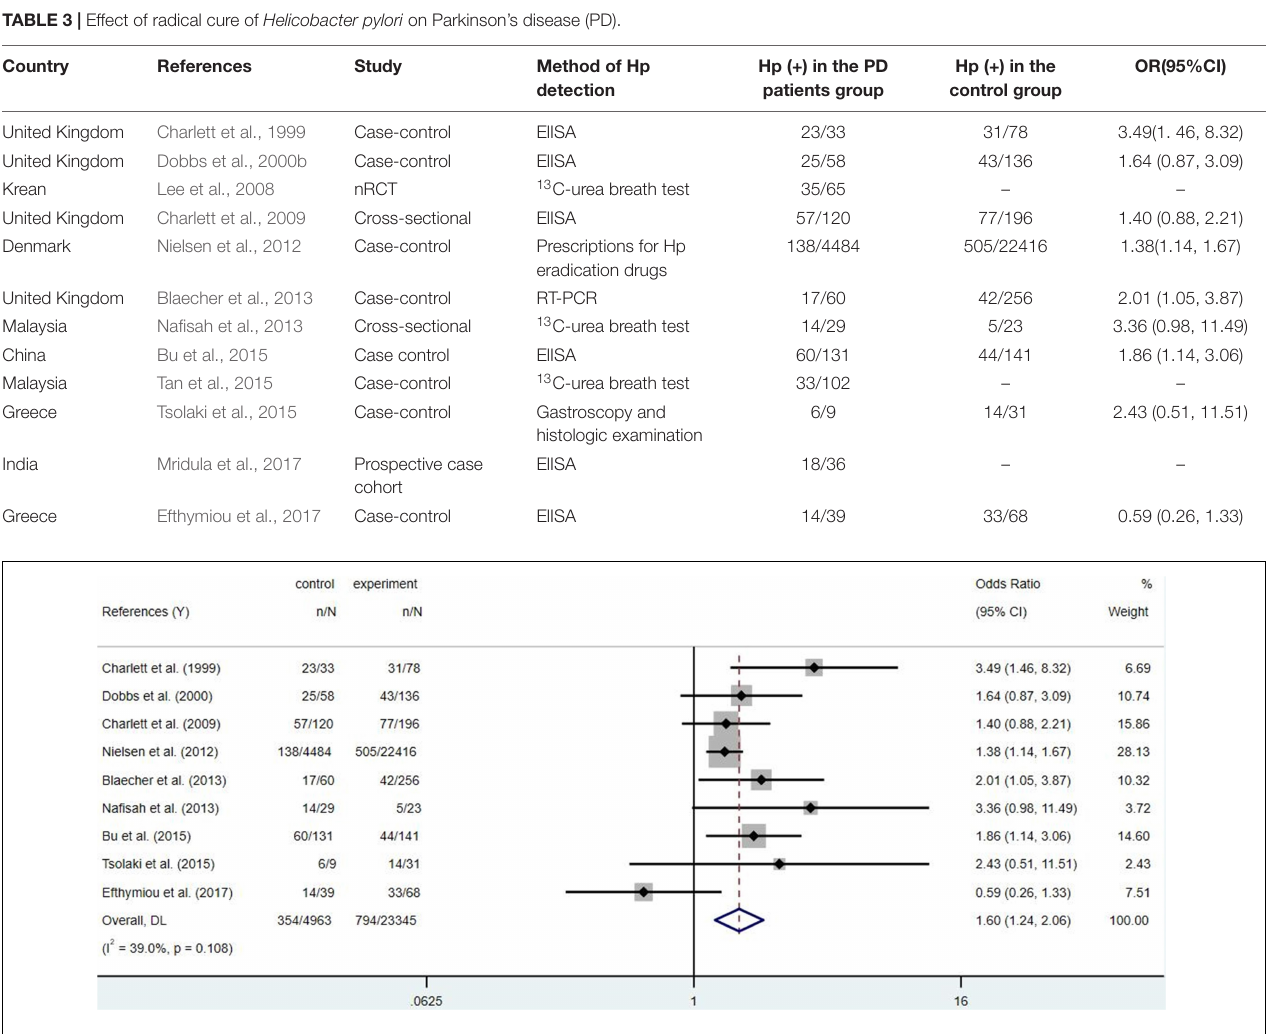
FIGURE 2 | Forest map of Helicobacter pylori ( Hp ) infection and the Parkinson’s disease (PD) risk.